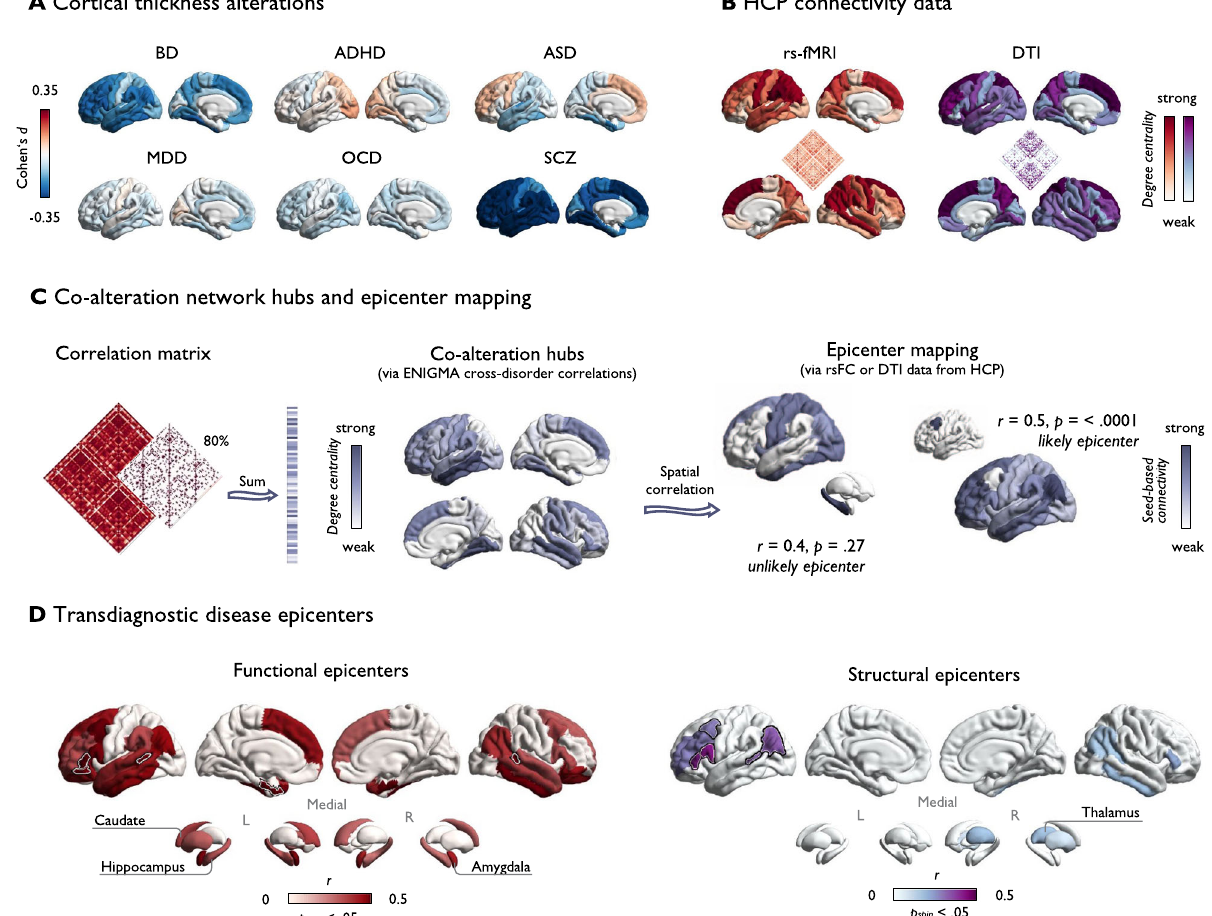
Fig. 1 | Hubs and epicenters shaping transdiagnostic co-alteration patterns. A Disorder-speci fi c Cohen ’ s d maps indicating case-control differences in cortical thickness. B Normativeconnectivitymatricesderivedfromresting-statefunctional magneticresonanceimaging(rs-fMRI)anddiffusion-weightedtensorimaging(DTI) from the Human Connectome Project (HCP 45 ) and hubs (degree centrality). C Left: Computation of co-alteration hubs. Degree centrality wascomputed asthe sum of above-threshold (80%) connections at each parcel using disorder maps from the Enhancing Neuroimaging Genetics through Meta-analyses (ENIGMA) consortium. Right: Visualization of the epicenter mapping approach using resting state func- tional connectivity (rsFC) or DTI. Seed-based connectivity pro fi les were system- atically correlated with co-alteration hubs (using Pearson ’ s r and assessing